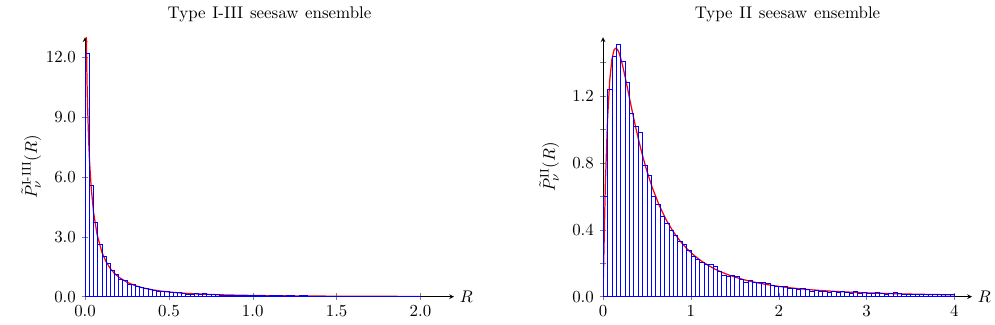
Figure 5 . Probability density functions for the ratios of the complex seesaw ensembles with N = 3. The red curve corresponds to the analytic result while the histogram corresponds to numerical results (with 2 : 5 10 4 dimensionless light neutrino mass matrices generated). The left and right (cid:2) plots show the pdfs for the ratios of the type I-III and the type II seesaw mechanisms respectively. The singular values are ordered such that 0 ^ m 1 ^ m 2 ^ m 3 and an extra factor of 3! is introduced (cid:20) (cid:20) (cid:20) to correct the singular value